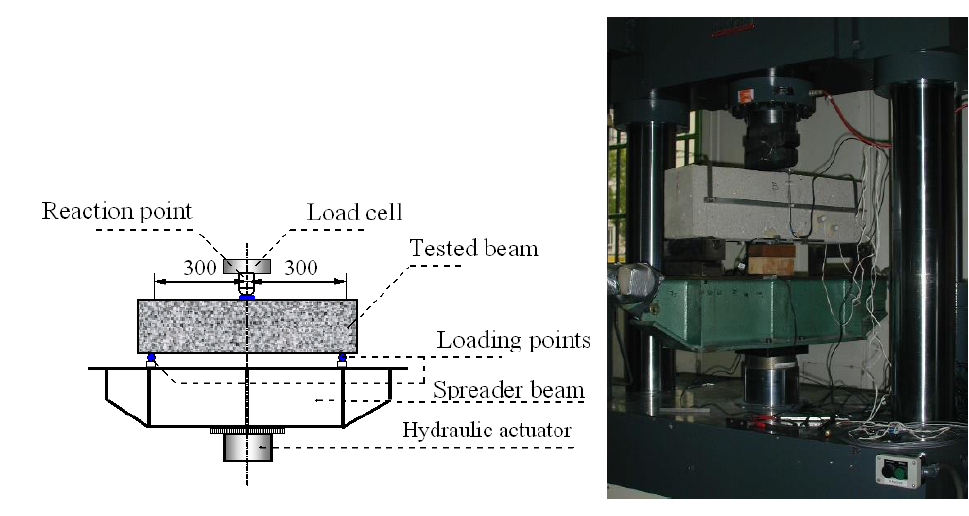
Figure 3. Three-point bending test setup.